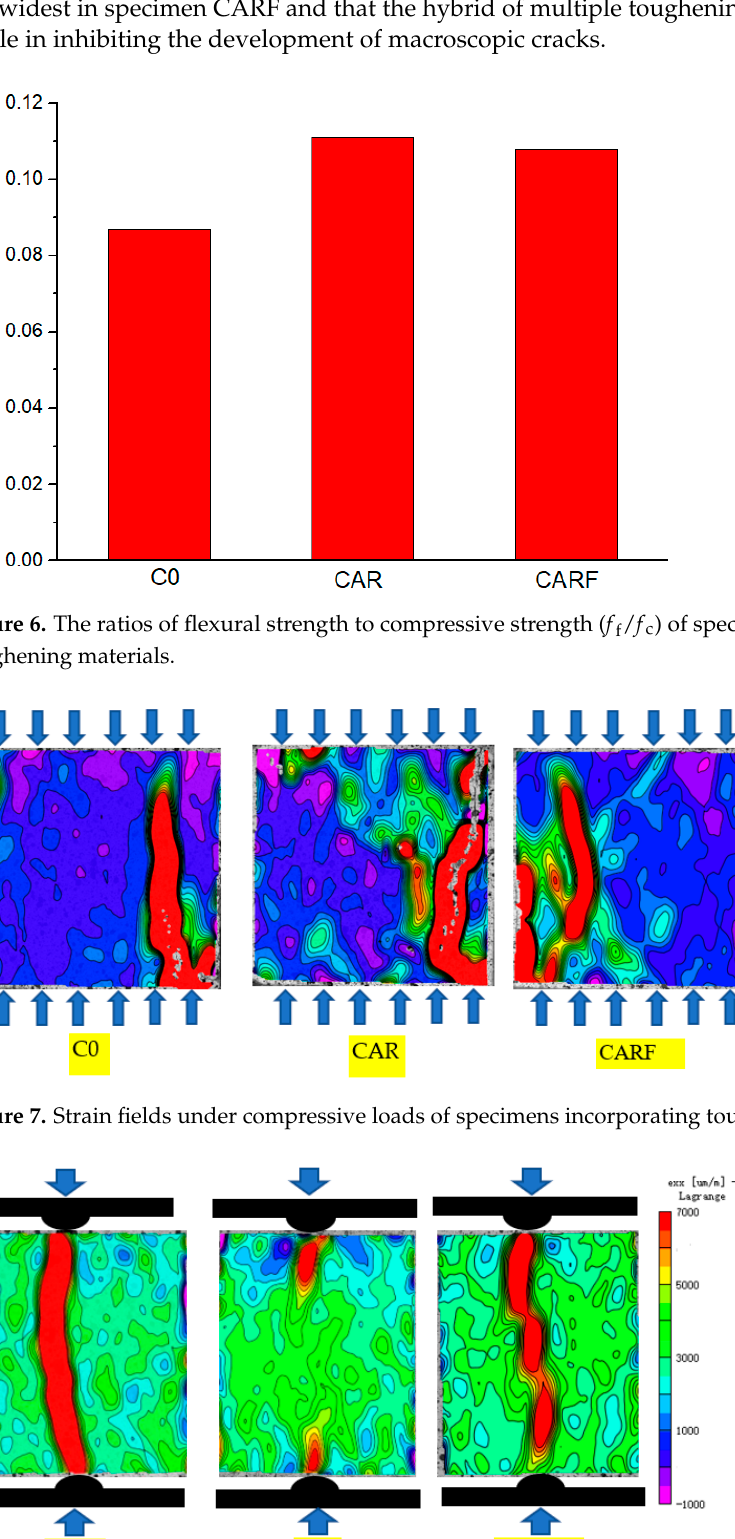
Figure 8. Strain fields under splitting loads of specimens incorporating toughening materials.